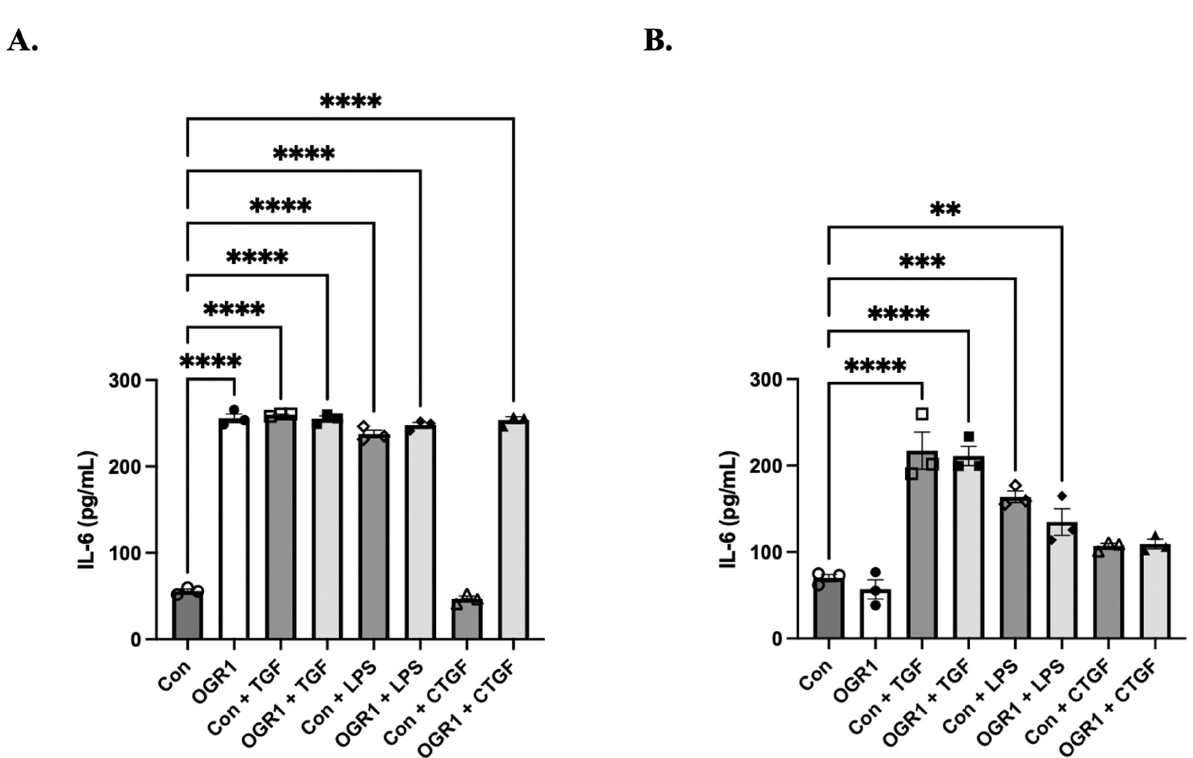
Figure 7. OGR1 is pro-inflammatory in 16-HBE but not in healthy human fibroblasts. Here, 16-HBE cells were treated with either control (GFP) or OGR1 plasmids followed by treatment with TGF- β , LPS, or CTGF, and secreted IL-6 levels were measured via ELISA. In 16-HBE cells, OGR overexpression alone caused significant IL-6 secretion ( A , **** p < 0.0001). As expected, TGF- β , LPS, and CTGF also induced significant IL-6 secretion ( A , **** p < 0.0001 for all significant treatment conditions). However, we did not observe an additive or synergistic effect with OGR1 and other cytokines/growth factors. In contrast, OGR1 overexpression did not induce IL-6 secretion in fibroblasts ( B ). However, TGF- β and LPS did cause significant increases in secreted IL-6 ( B , **** p < 0.0001, *** p = 0.0002, ** p = 0.0057), whereas CTGF did not. Interestingly, OGR1 overexpression appears to have no effect on inflammatory signaling in fibroblasts. Open circles represent basal control conditions and closed circles represent OGR1 under basal conditions. Open boxes represent control plasmid plus TGF- β , and closed boxes represent OGR1 plasmid plus TGF- β . Open diamonds represent control plasmid plus LPS, and closed diamonds represent OGR1 plasmid plus LPS. Open upward arrows represent control plasmid plus CTGF, and closed upward arrows represent OGR1 plasmid plus CTGF.